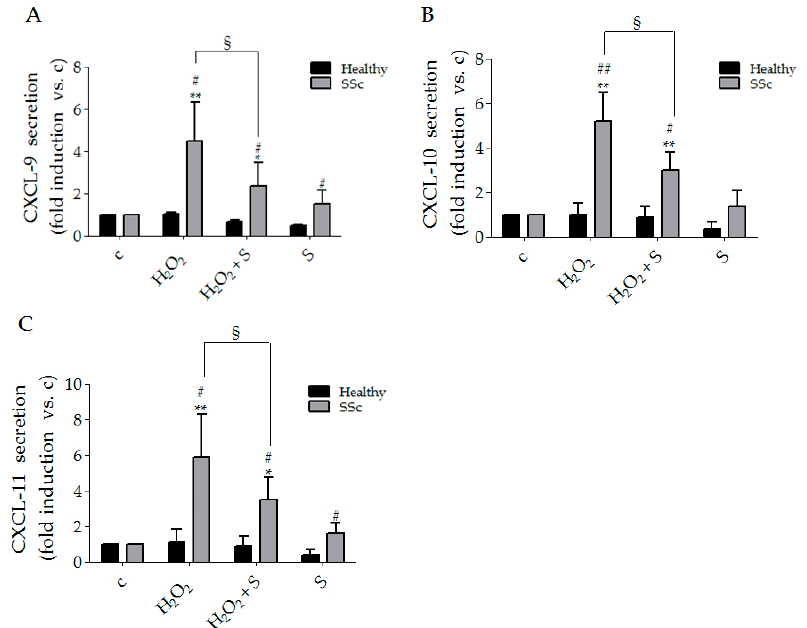
Figure 1. Supernatants from human healthy (black columns) and SSc (grey columns) fibroblasts cultures exposed to H 2 O 2 (100 µ M, 24 h) in the presence or absence of sildenafil (1 µ M). Cells were analyzed for CXCL-9 ( A ), CXCL-10 ( B ) and CXCL-11 ( C ) content. Data are presented as the fold increase vs. control taken as 1 ± SEM ( n = 3). Statistical significance was determined using ANOVA with Bonferroni’s post-hoc test. * p < 0.05 and ** p < 0.01 vs. relative control within group; # p < 0.05 and ## p < 0.01 vs. H 2 O 2; § p < 0.05 vs. corresponding treatment between groups; c , control group; S , sildenafil. Experiments were repeated at least three times ( n = 3) with essentially identical results.